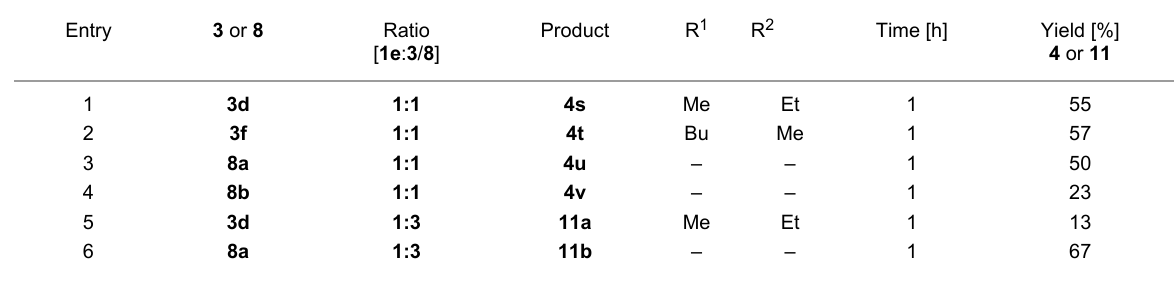
Table 3: Reaction of dithiolanylium TFB 1e with ketones 3d , f or 8a , b